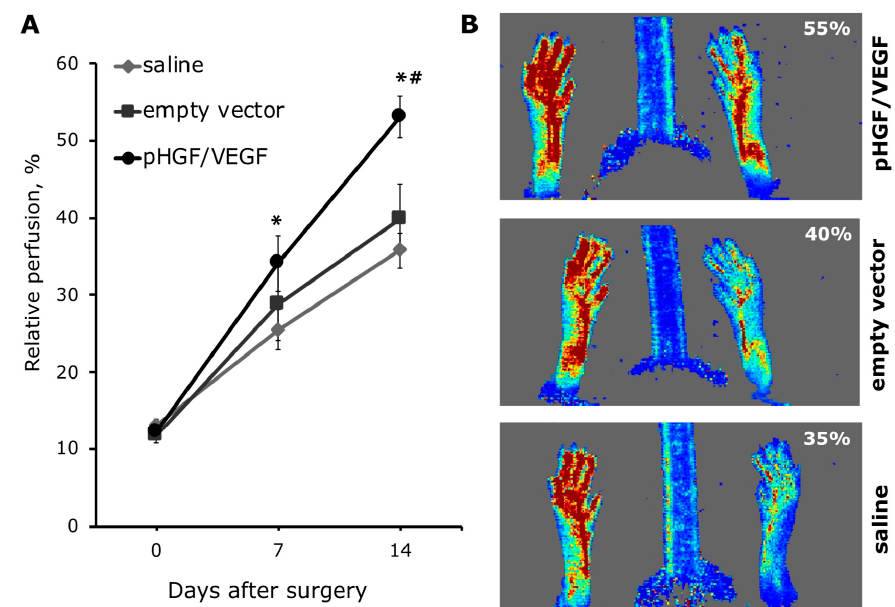
Figure 7. Evaluation of murine ischemic limb perfusion in study groups. ( A ) Limb perfusion graph indicating relative perfusion values; for the pHGF / VEGF group: * p = 0.05 and p = 0.006 vs. saline group at days 7 and 14, respectively; * # p = 0.018 vs. empty vector at day 14. ( B ) Representative Laser Doppler images of subcutaneous blood flow in mice from experimental groups obtained at day 14 after ischemia induction and plasmid injection. Data are presented as mean ± SEM.